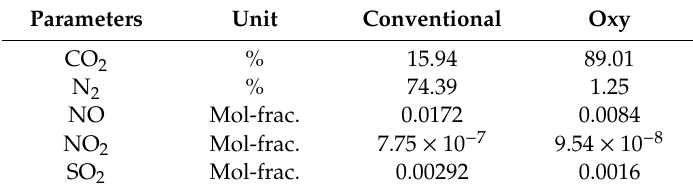
Table 4. Average flue gas composition of conventional and oxy combustion (3.5% Excess O 2 ).